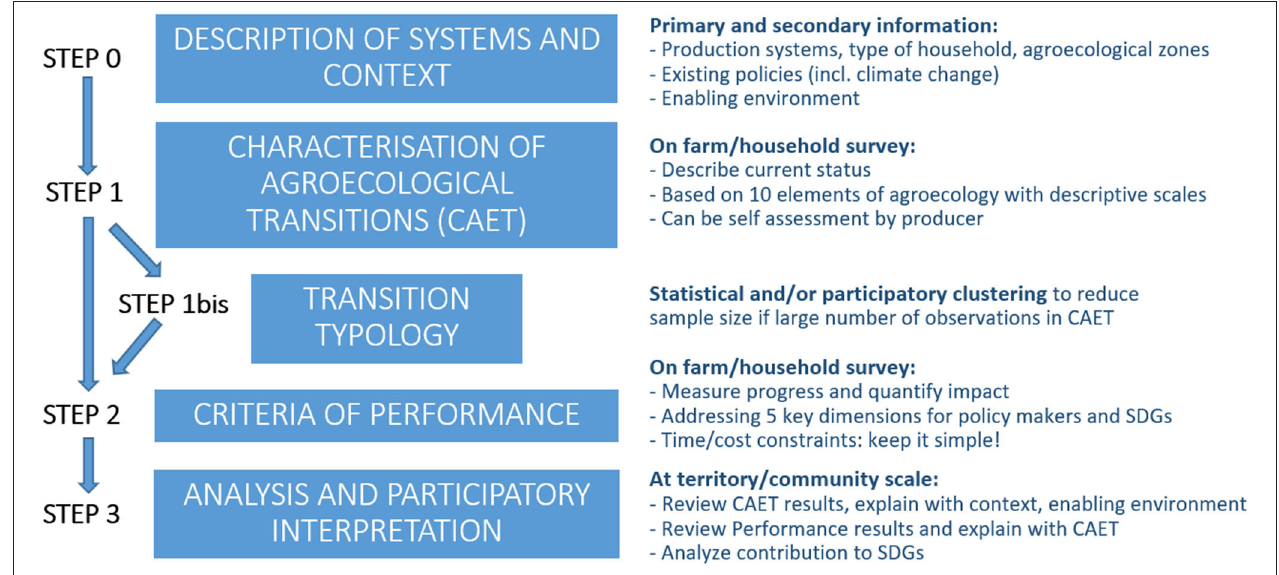
FIGURE 1 | The stepwise approach for implementing the Tool for Agroecology Performance Evaluation (TAPE) (FAO, 2019a).